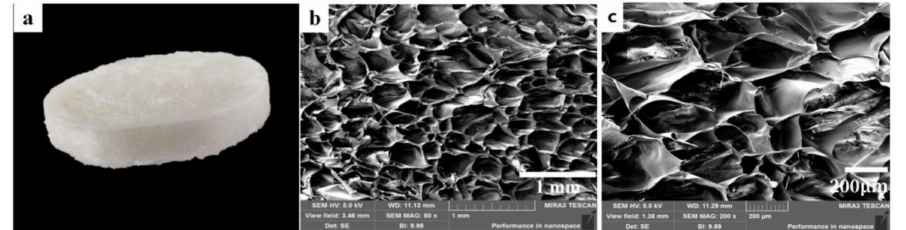
Figure 3. Morphology of the CTS-NF sponge ( a ) SEM micrograph of the cross-section (80 × ) ( b ). the internal section (200 × ) ( c